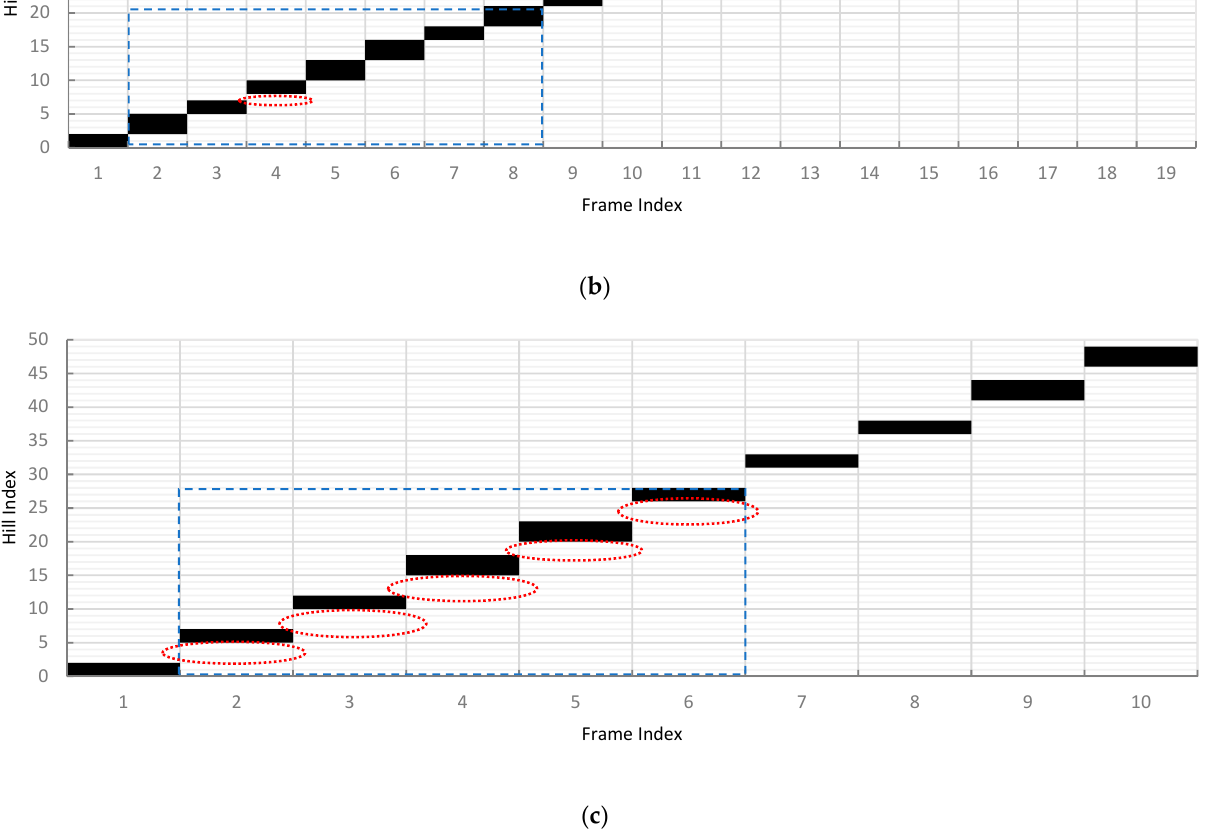
Figure 10. Range of plant hill indices that were detected per frame along the first 10 m of the simulated field at 2.4 fps , 0.5 m capture width, 0.2 m hill spacing at ( a ) 0.1 m/s, ( b ) 1.3 m/s, and ( c ) 2.5 m/s. Blue broken lines enclose a detection pattern, while broken red lines specify the missed plant hills.